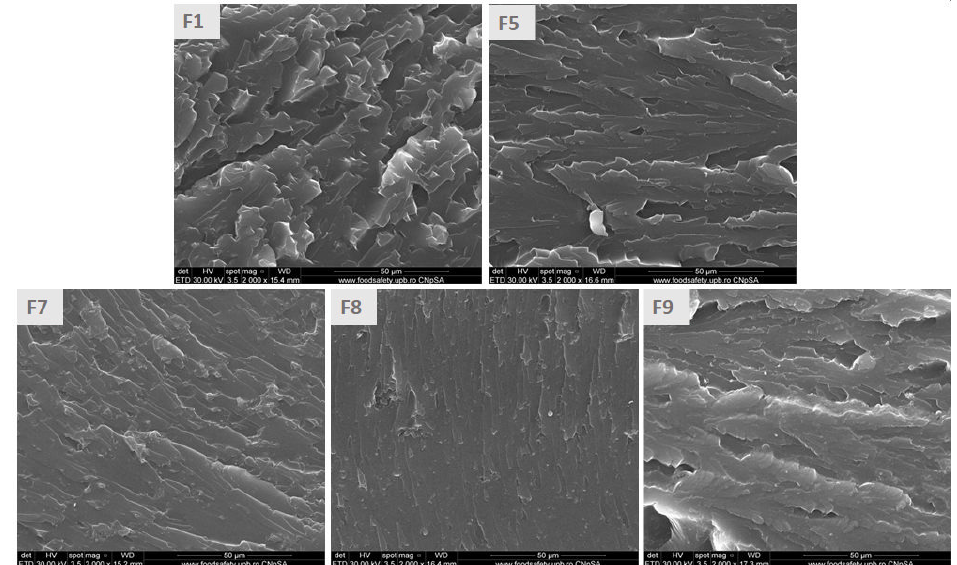
Figure 8. SEM images for different ELALO-based materials ( ELALO (F1), ELALO-EpLnK1 (F5), ELALO-DBS-EpLnK1 (F7), ELALO-Span-EpLnK1 (F8), ELALO-HSA-EpLnK1 (F9); 2000× magnification).